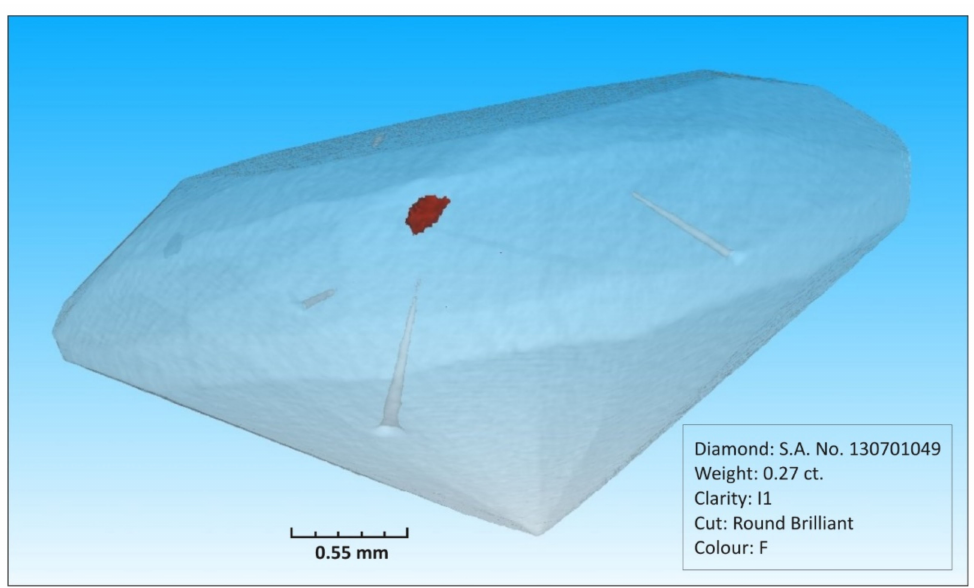
Figure 1. A 3D computed tomography (CT)-scan image of a diamond revealing drill channels and an inclusion, modified after Roux